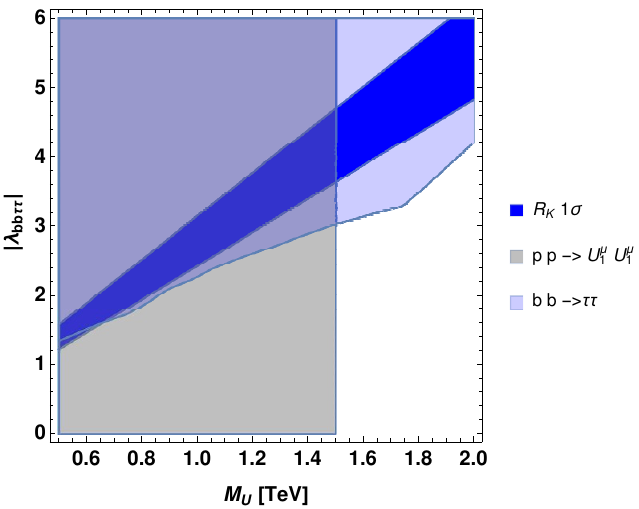
λ bbττ plane in the U U model: the 1 σ allowed range from − | | ττ search [24], and the region excluded by LHC →